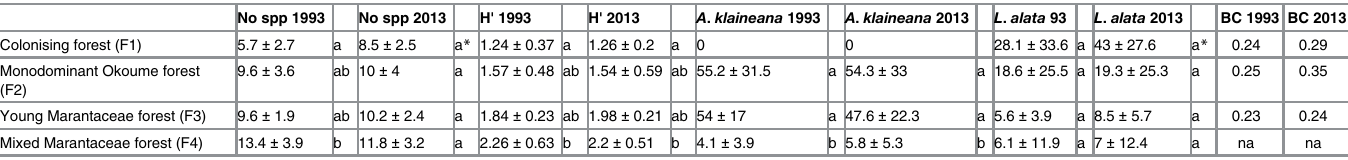
Table 4. Species richness (No spp), Shannon index (H ’ ), A . klaineana dominance (in %BA), L . alata dominance (in %BA) and the Bray-Curtis (BC) Index of dissimilarity in 1993 and 2013 (compared with the following vegetation type in the succession in 1993) per forest type.